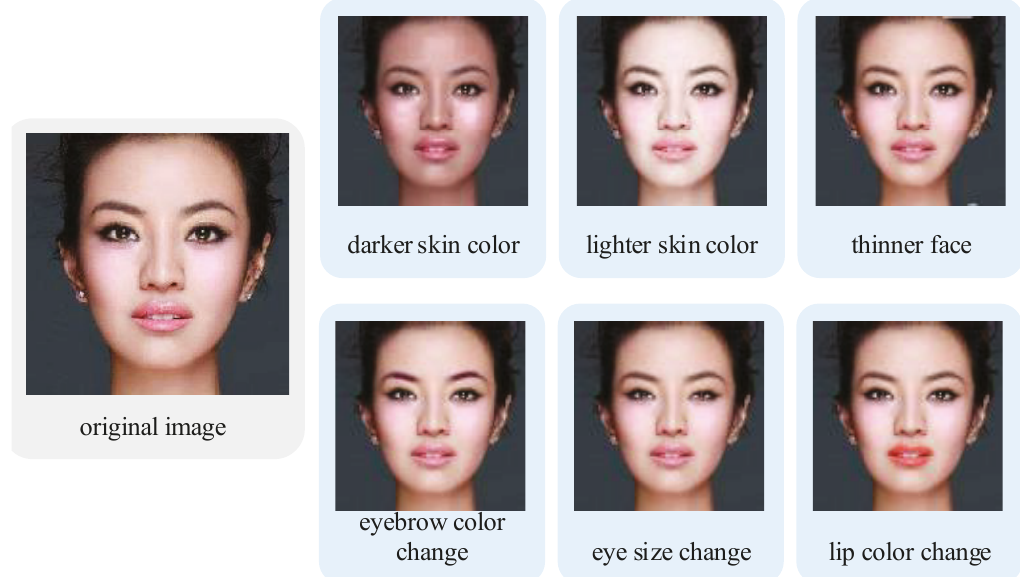
Figure 4. The example of artificial images in FOFDTD.